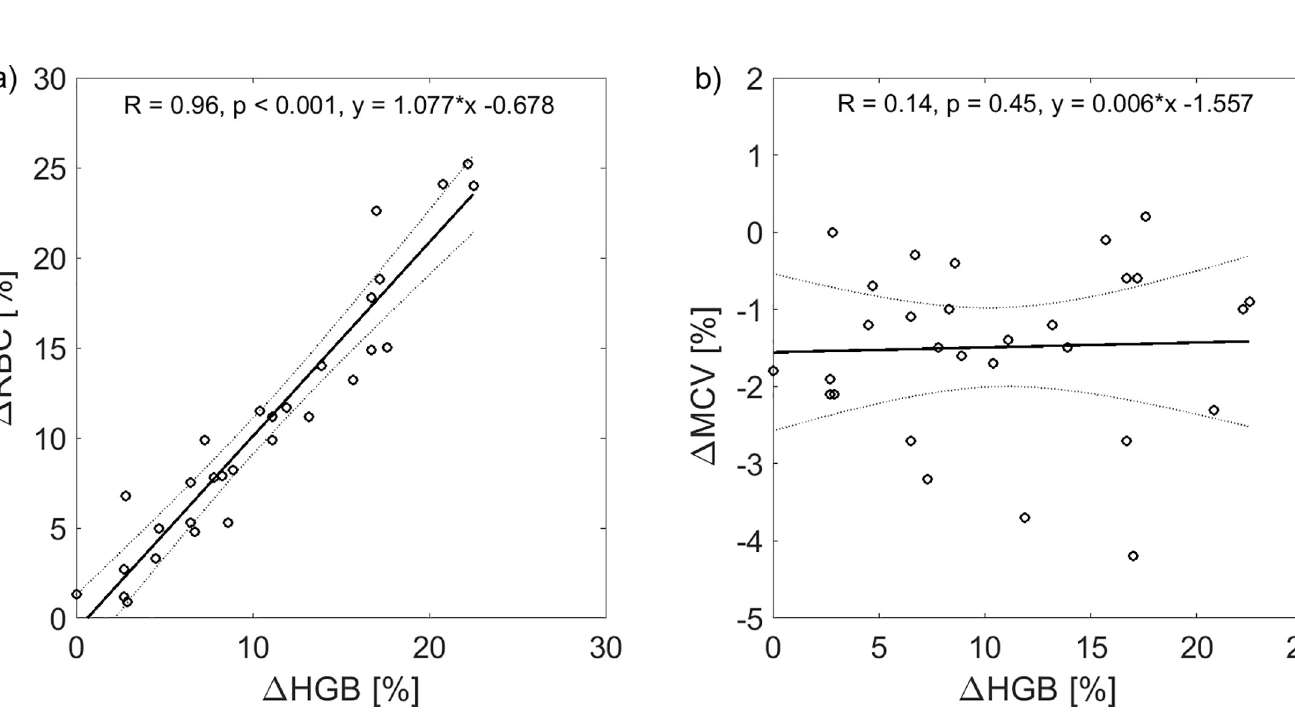
Fig 3. Correlation between dialysis-induced changes in hematocrit, hemoglobin and total blood protein. Relative changes of hemoglobin ( Δ HGB) paired with a) relative changes of hematocrit ( Δ HCT) and b) relative changes of total blood protein ( Δ TBP) during all analyzed hemodialysis sessions plotted against the identity line.